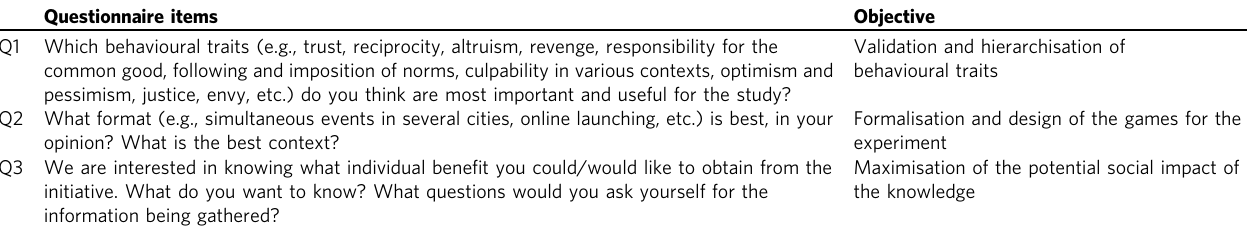
Table 2 Questionnaire with open-ended question for working session participants, associated with the objective of each